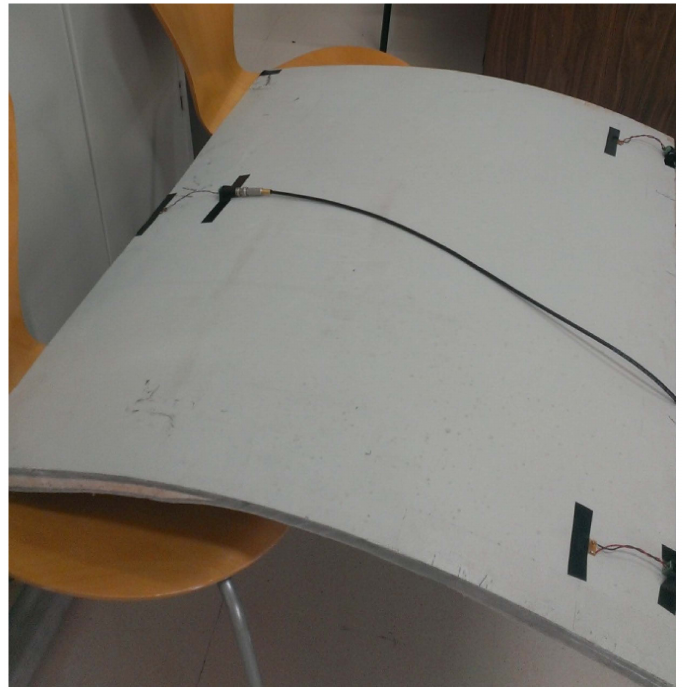
Figure 1. Wind turbine section with sensors for acoustic emission